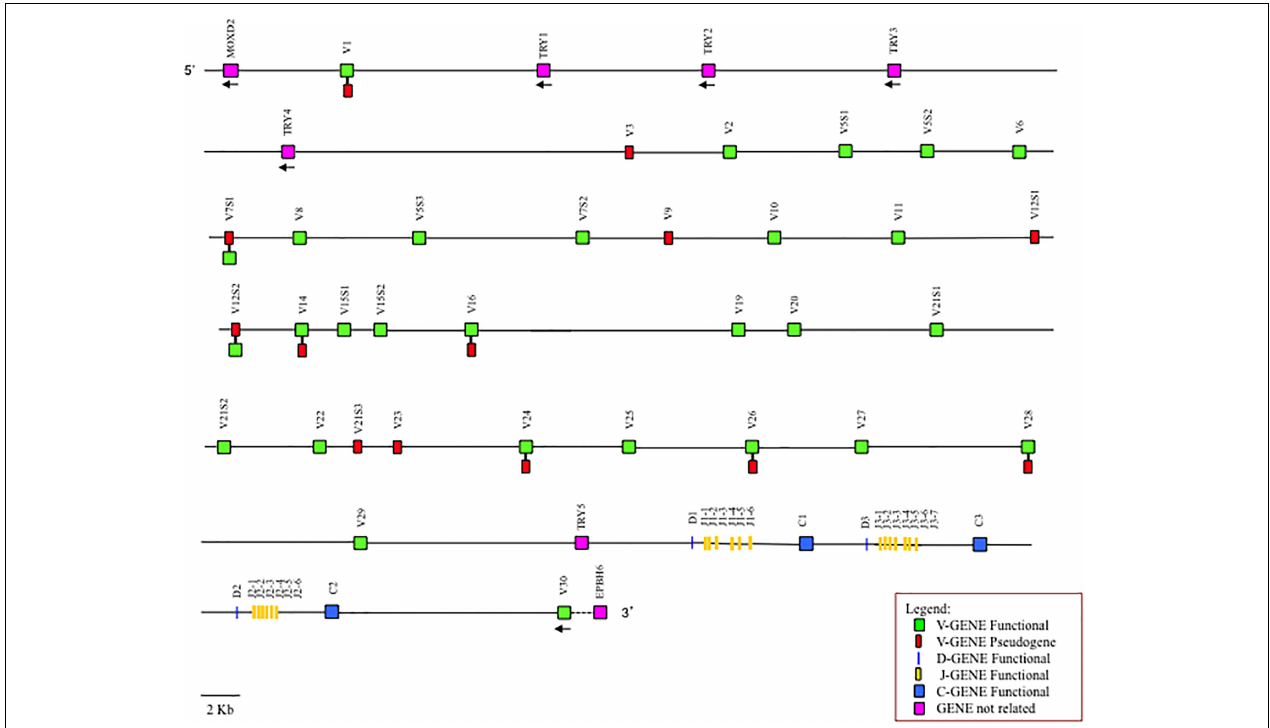
FIGURE 5 | Virtual map of the TRB locus of Old World camelids. The map was constructed according to the indications given in the text. The presence of differences in the functional status of the TRBV genes between the three species is